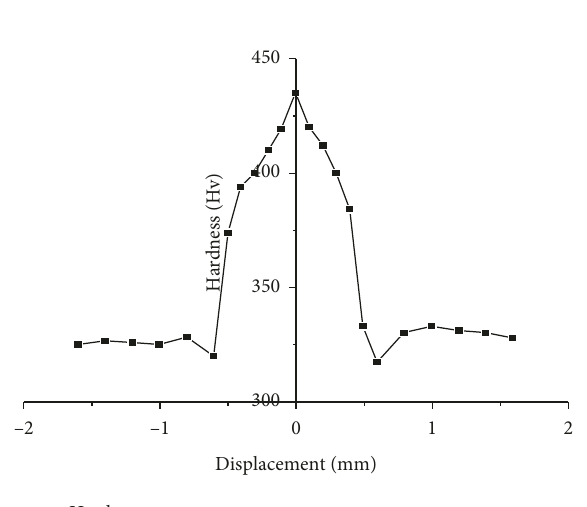
Figure 12: SEM fractographs of fractured tensile specimen.